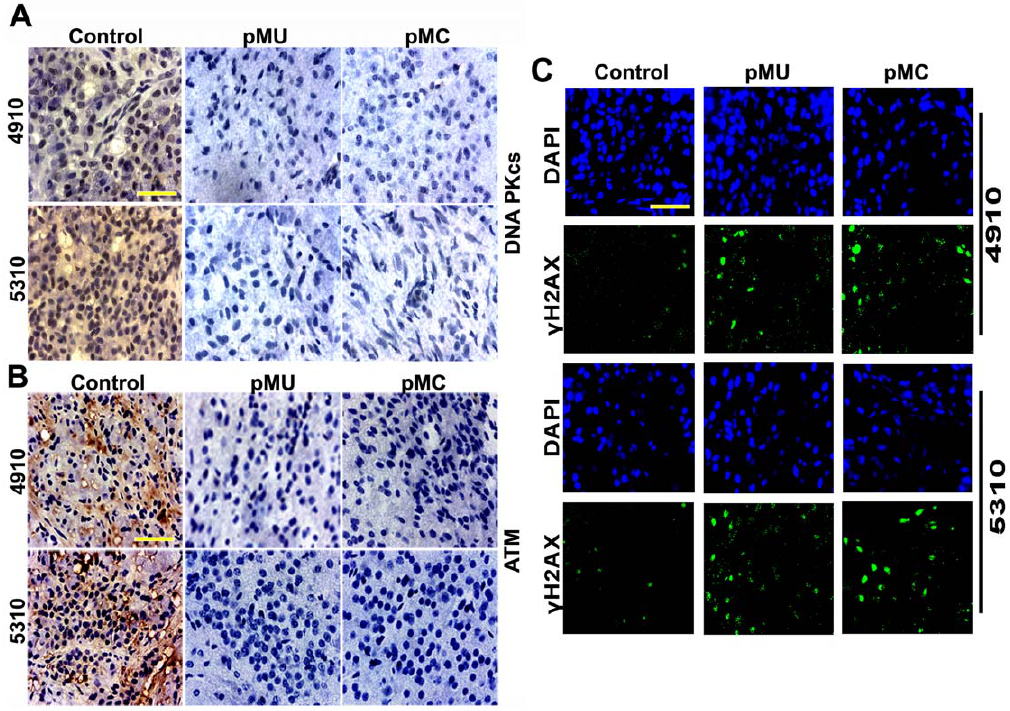
Figure 6. Immunohistochemistry analysis of paraffin embedded tissue sections prepared from nude mice implanted orthotopically with glioma cells and treated with pMU and pMC. IHC analysis shows expression of DNA PKcs (A), ATM (B) and c H2AX (C) in both pre- established 4910 and 5310 glioma tumors treated with pMU and pMC constructs. Magnification 60 6 . Bar=20 m m. Each experiment was repeated 3 times.